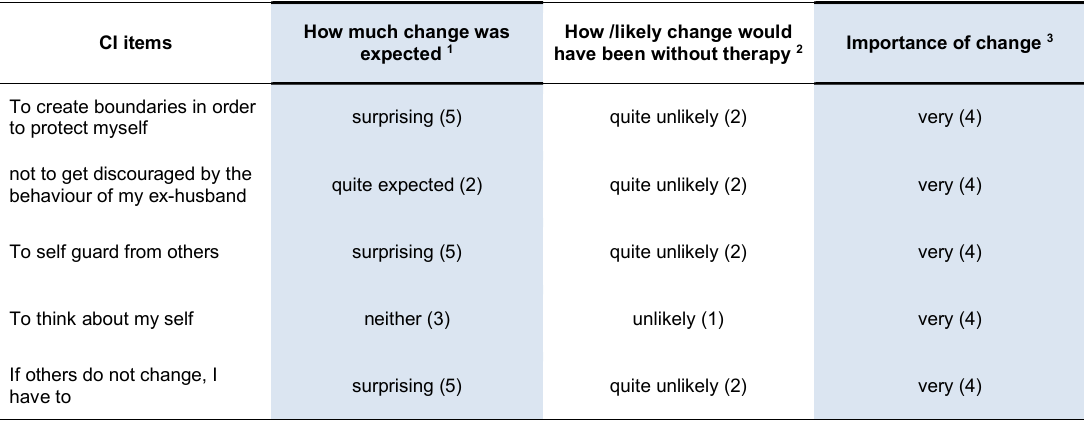
Table 4: Penelope’s changes identified in Change Interview – CI (Elliott et al. 2001) 1 The rating is on a scale from 1 to 5; 1= expected, 3= neither, 5= surprising. 2 The rating is on a scale from 1 to 5; 1=unlikely, 3=neither, 5=likely. 3 The rating is on a scale from 1 to 5; 1=slightly, 3 = moderately, 5=extremely.